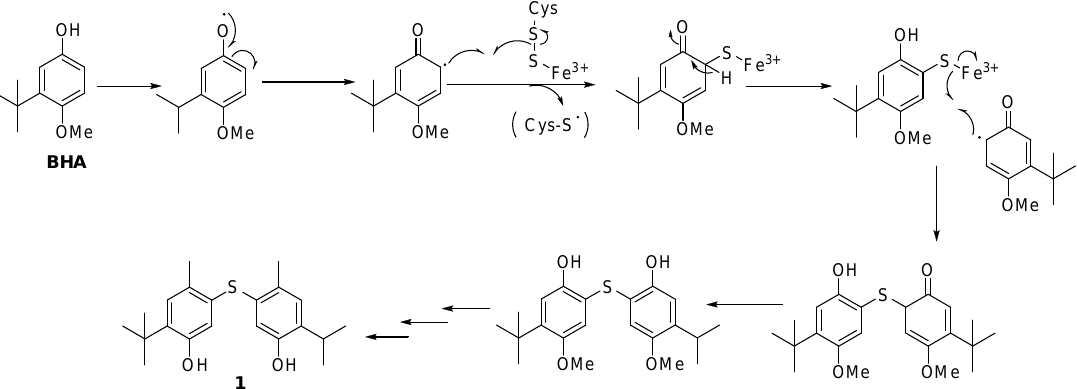
Figure 6. Putative biosynthetic pathway for Compound 1 from BHA supported by an iron–sulfur cluster protein with cysteine as a sulfur donor.